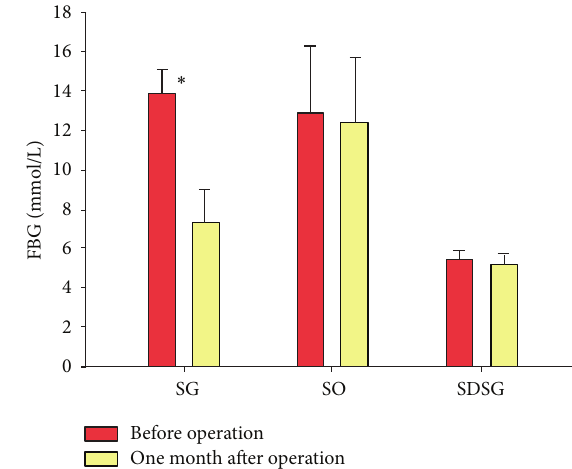
Figure 2: Changes of rat’s FBG among groups. Sleeve gastrectomy group (SG), sham-operation group (SO), and sleeve gastrectomy of SD rats group (SDSG). Compared with SO group, ∗ 𝑃 < 0.05